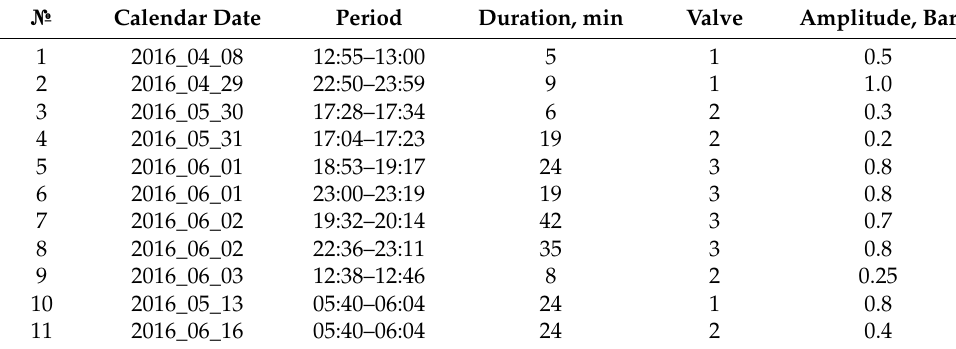
Table 1. Indicators of the processes of HFOs/chatter.